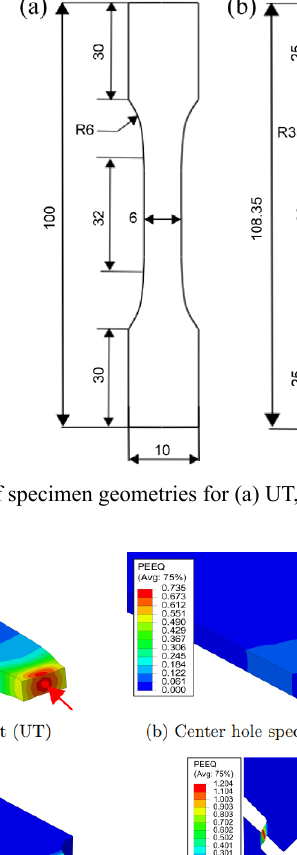
| https://mc03.manuscriptcentral.com/friction